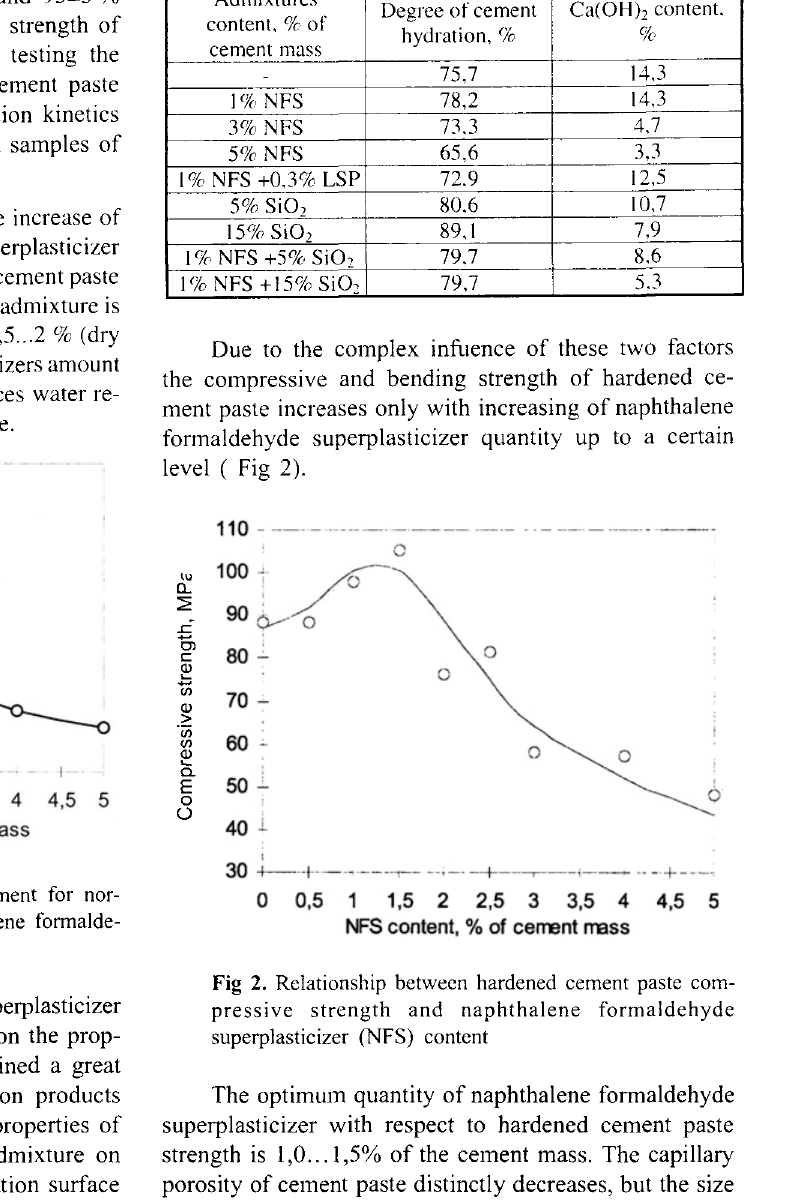
Table 1. The influence of naphthalene formaldehyde super plasticizer (NFS), lignosulfonates (LSP) and silica fume (Si0 2) on the degree of cement hydration and hydration products Admixtures Degree of cement Ca(OHh content. content.% of hydration. %